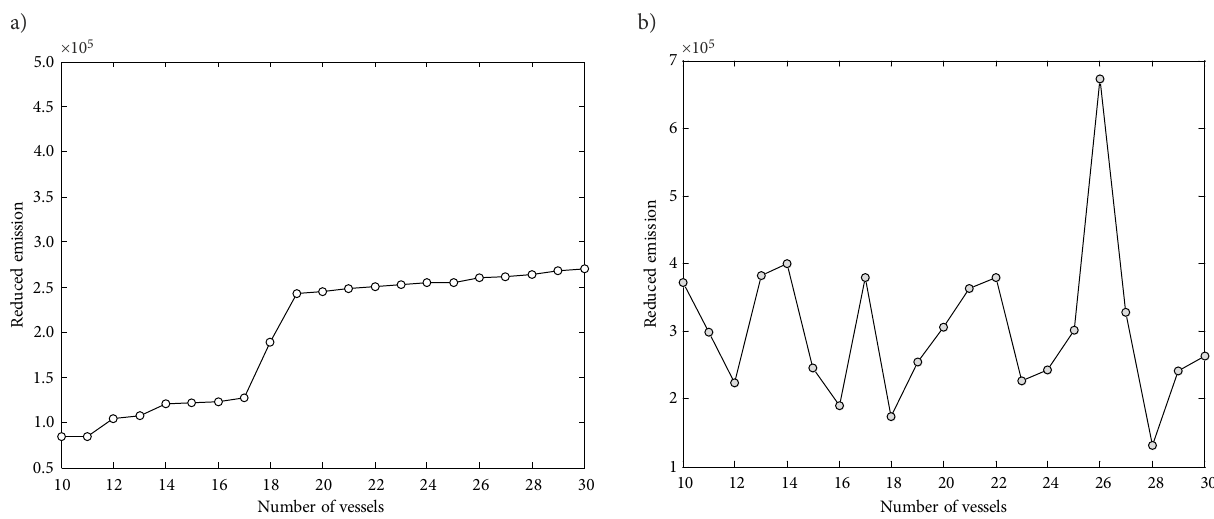
Figure 6. Reduced emissions varying with number of vessels: a – a sample; b – average reduced